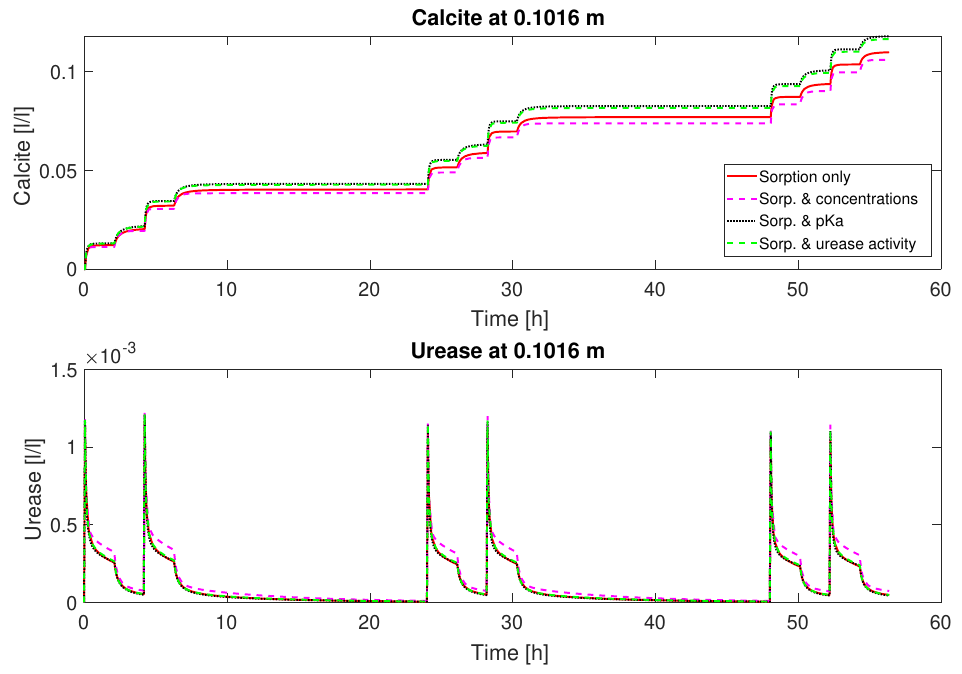
Figure 7. Prediction of concentration measurements at 10.16 cm from the inlet for column experiment #2 (0.66 M mineralization medium concentration): Note that, during this experiment, urease was only injected before every odd-numbered mineralization-medium